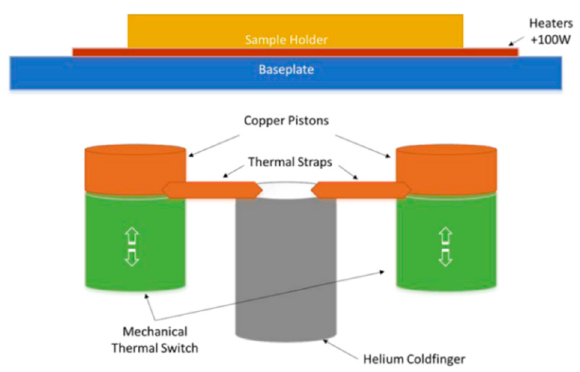
Figure 1. Thermal vacuum cycle conceptual Figure 1. T hermal vacuum cycle conceptual design.